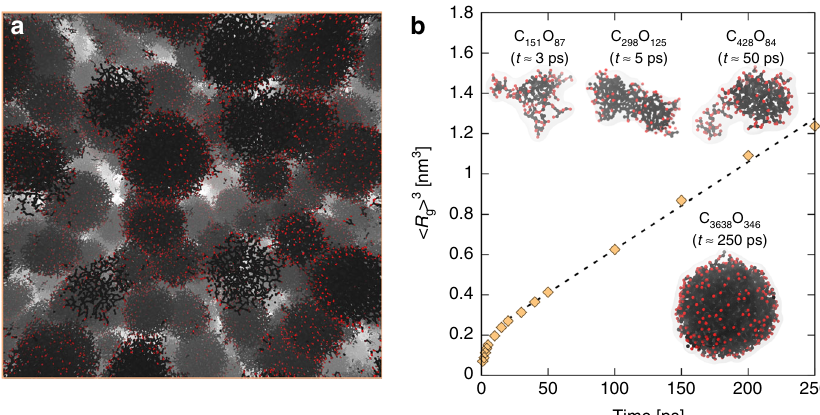
Fig. 4 MD structure and evolution of carbon clusters. a Snapshot of the 1.25 million atom simulation at 0.25 ns. Carbon and oxygen atoms are shown as black and red, respectively; only atoms participating in cluster formation are shown, and connections between atoms are drawn only as a guide to the eye. b Average cluster size evolution (R g — radius of gyration) as a function of time; representative cluster snapshots are provided for various times along the simulation. A linear fi t to 20 ≤ t ≤ 250 ps is given by the dashed